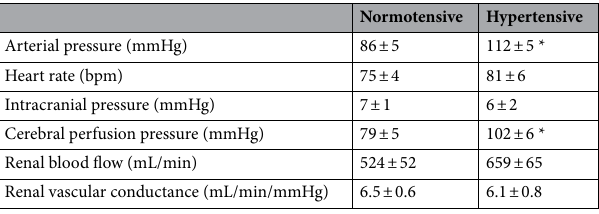
Table 1. Baseline levels of cardiovascular variables in normotensive and hypertensive